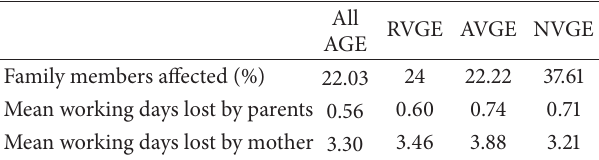
Table 2: Societal burdens due to RVGE, AVGE, and